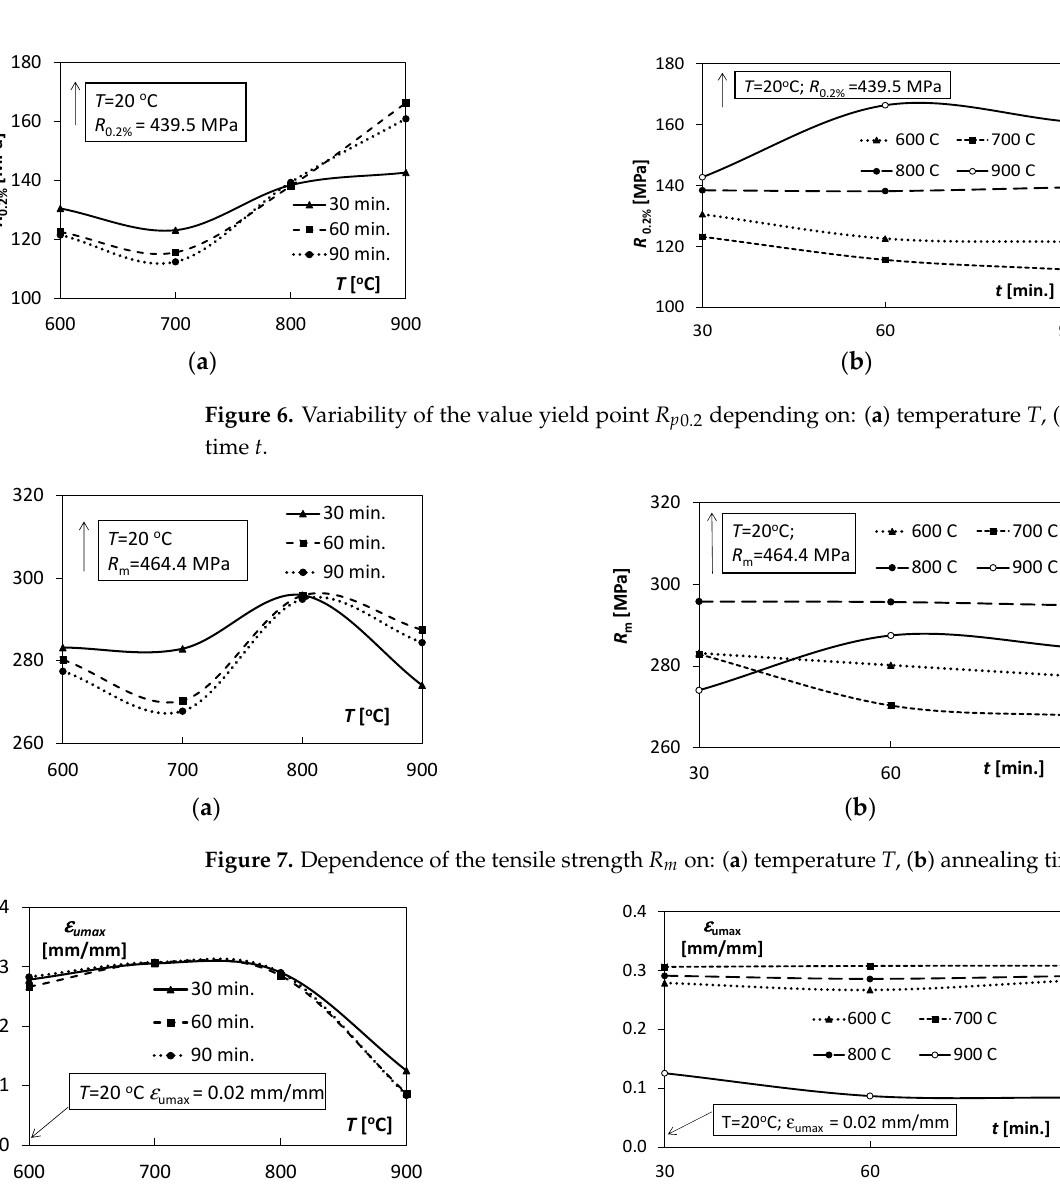
Figure 5. Exemplary of tensile curves for Ti/Cu bimetal samples unheated and annealed in the tem- perature range of 600–900 °C for t = 30 min.